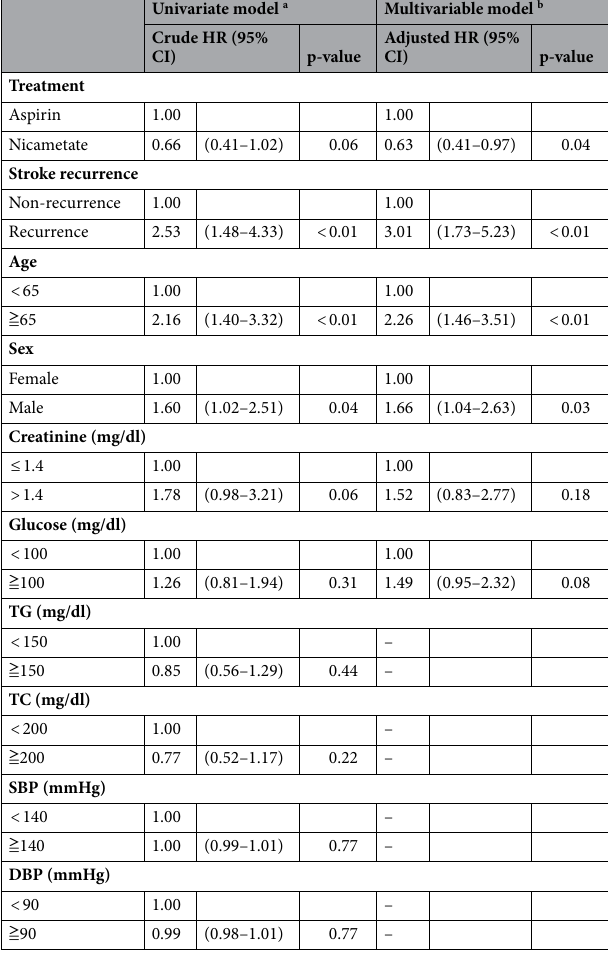
Table 2. Hazard ratios (HR) comparing nicametate with aspirin on cerebrovascular death in stroke patients using time-dependent Cox model. a All univariate analysis incorporating recurrence as a time-dependent variable in the model. b Variables control in multivariable analysis including age, sex, stroke recurrence and glucose level when we compared nicametate with aspirin.